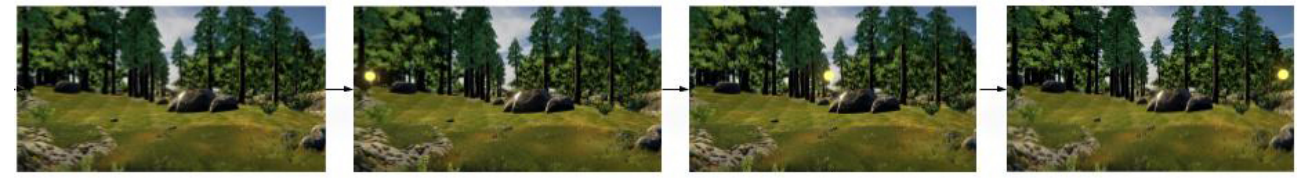
Figure 5. Subsequent scenes of Eye Movement Desensitisation and Reprocessing (EMDR) relaxation